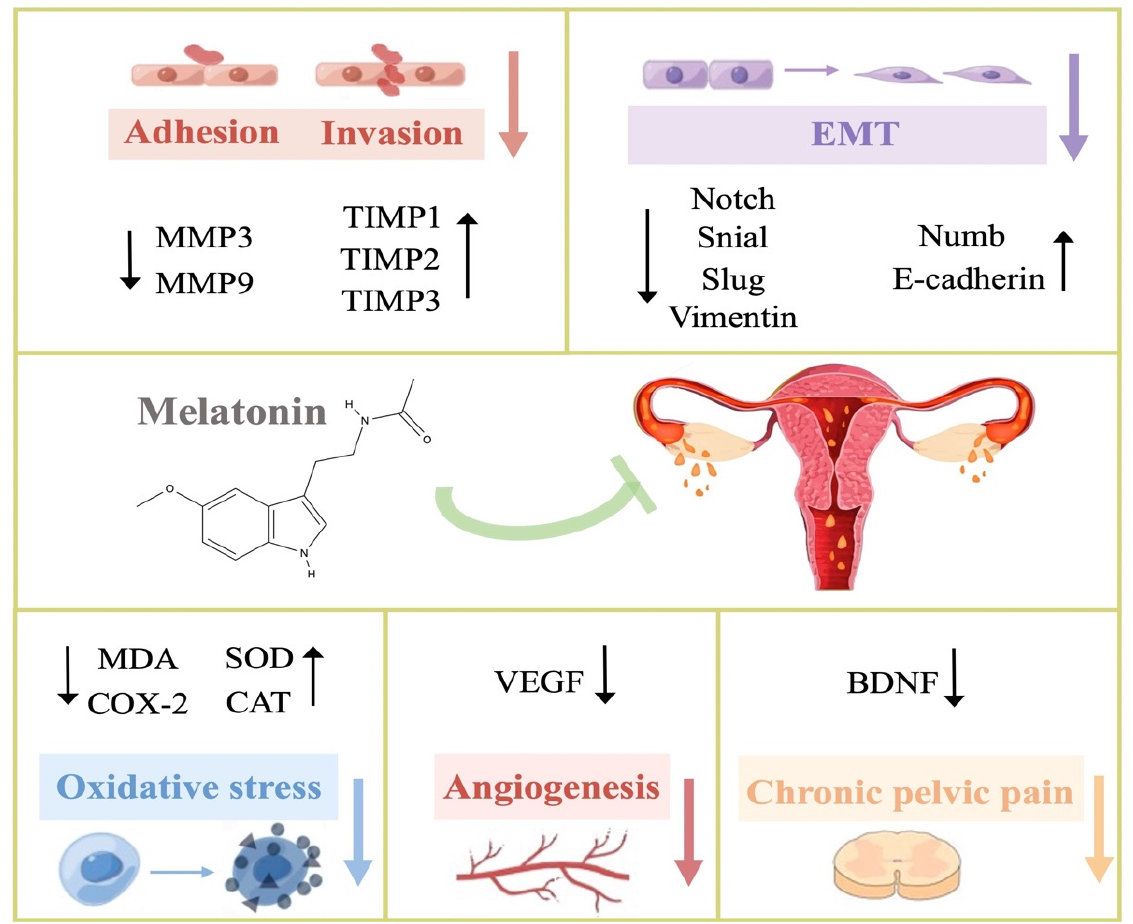
Figure 1. Therapeutic targets of melatonin toward inhibiting the development and progression of endometriosis. The effect of melatonin with respect to various molecular targets involved in the